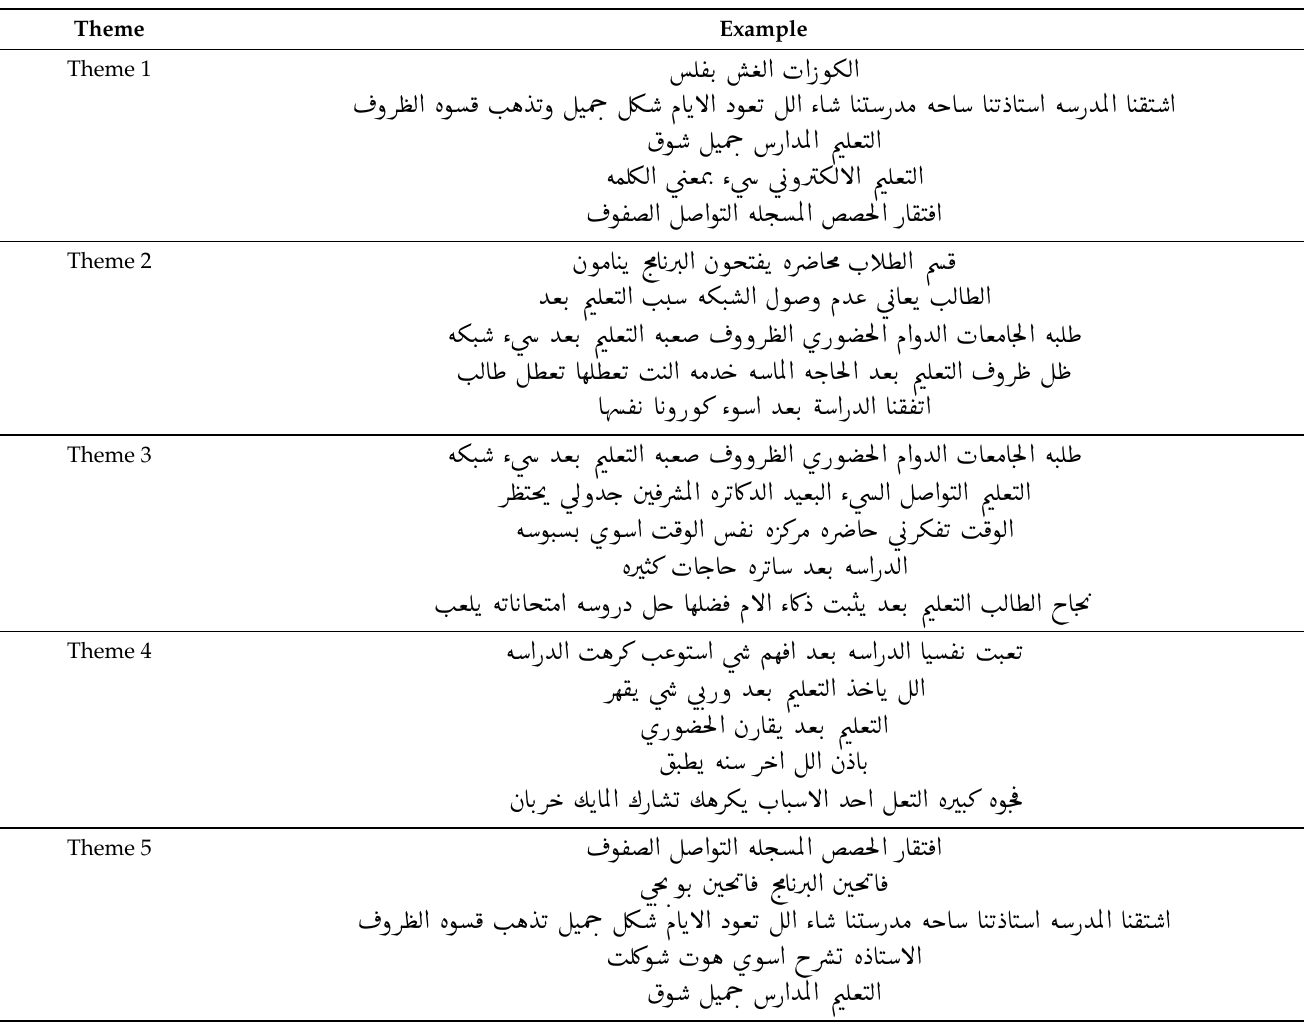
Table 2. Sample of the